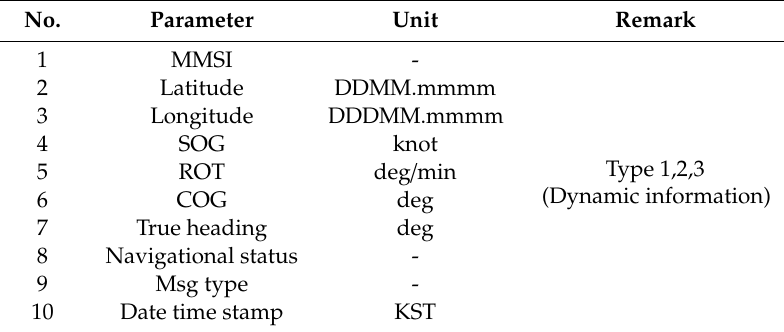
Table 3. Dynamic AIS data configurations.